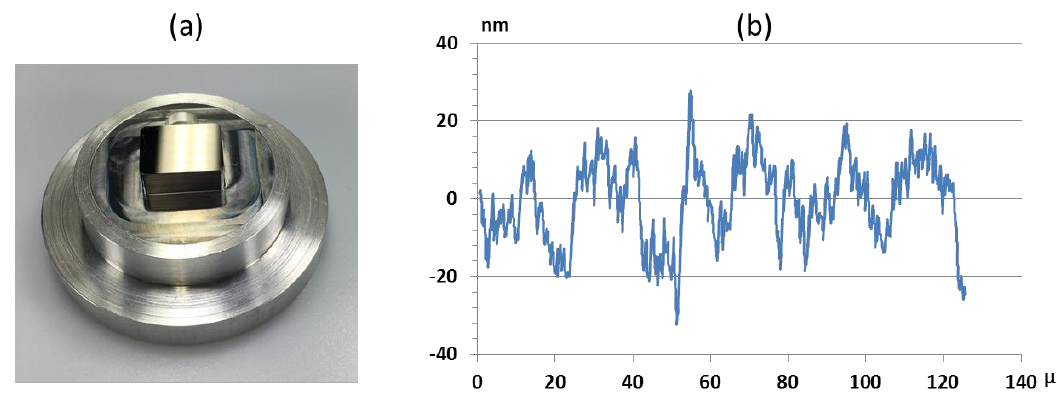
Figure 5. ( a ) Mold insert with flat optical surface after fly-cutting process; ( b ) Surface profile acquired by WLI.